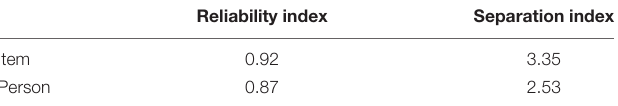
TABLE 3 | Item and person reliability. Reliability index